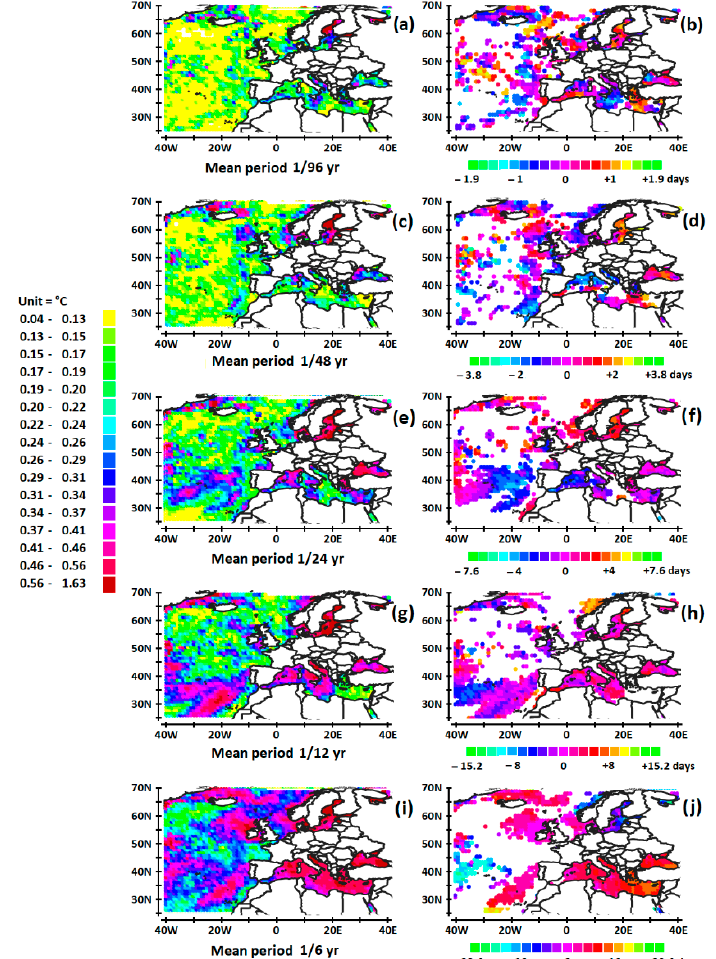
Figure 6. SST anomalies involved in extreme rainfall in Western Europe: amplitudes in ( a , c , e , g , i ) and phases in ( b , d , f , h , j ).